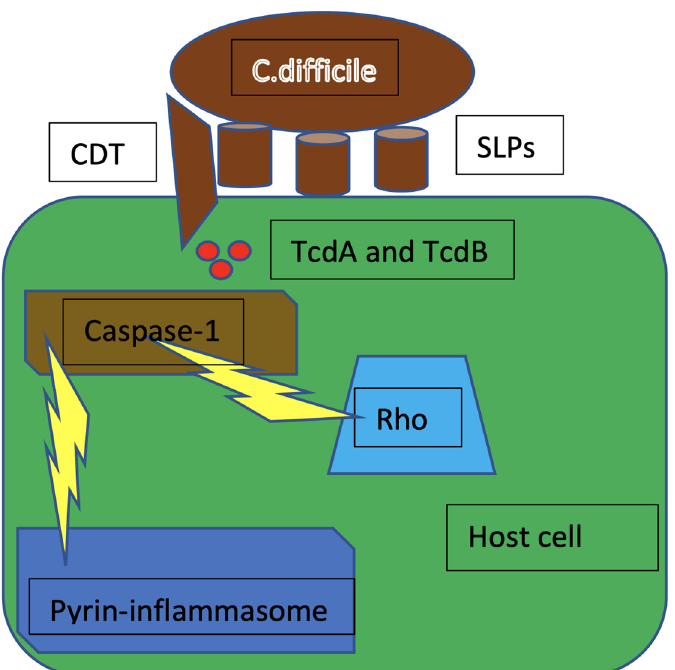
Figure 4. The inactivation of Rho by TcdA and TcdB causes cytoskeleton rearrangements that trigger pro-caspase-1 cleavage and activation, leading to the formation of pyrin inflammasome. CDT = C. difficile transferase; SLPs = surface layer proteins; TcdA = C. difficile toxin A; TcdB = C. difficile toxin B; Rho = rhesus homologous.